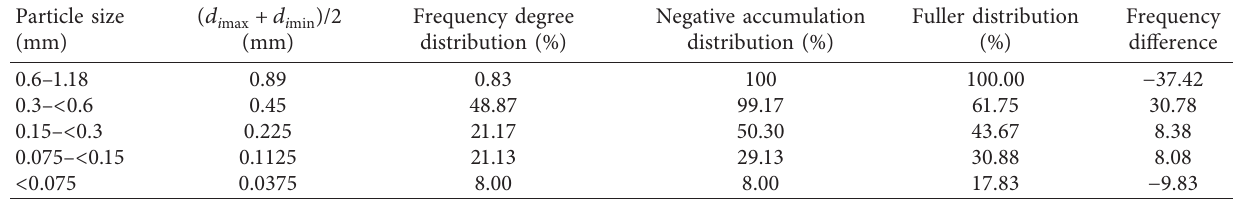
Table 6: Gradation of desert sand.